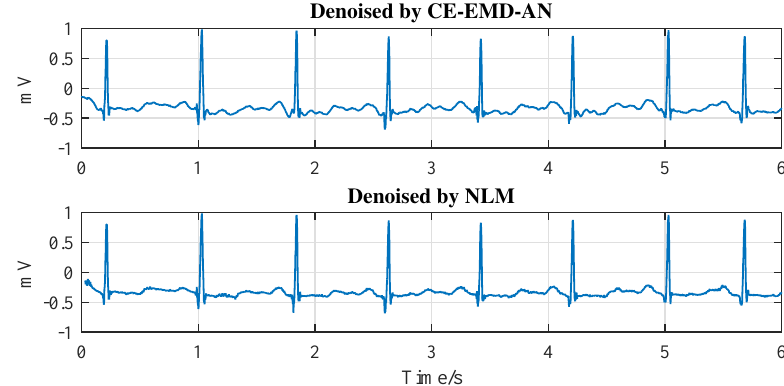
Figure 13. Comparison of waveform outputs of different algorithms for a normal ECG signal (No.100 in the MIT-BIH database).